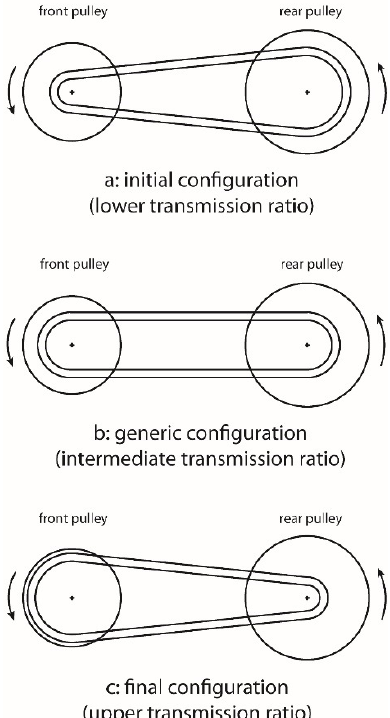
Figure 4. Front assembly configurations: initial/starting ( a ), intermediate ( b ), final ( c ).